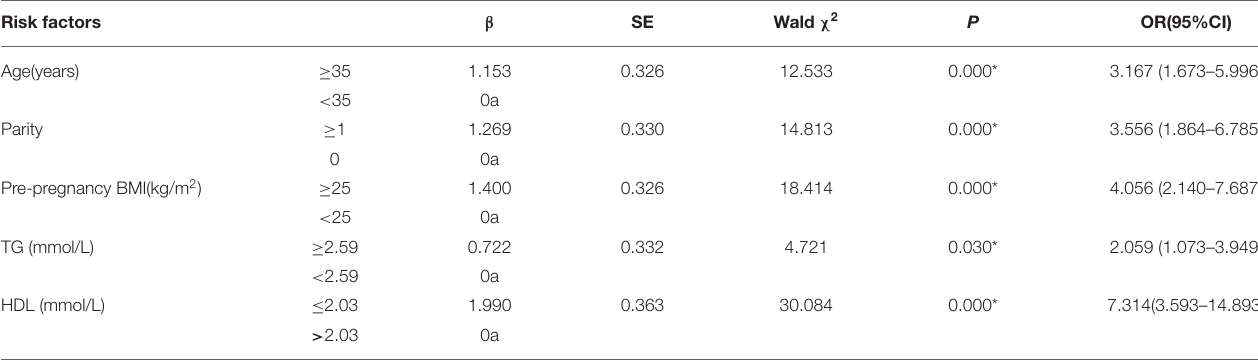
TABLE 4 | Multiple logistic regression of early-onset PE risk factors.